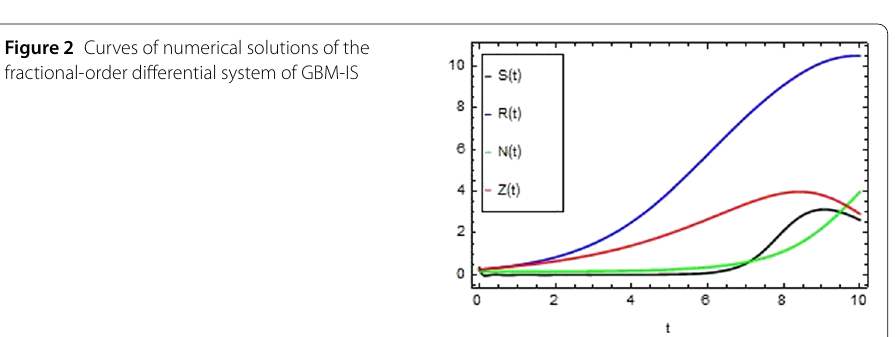
Figure 2 Curves of numerical solutions of the fractional-order differential system of